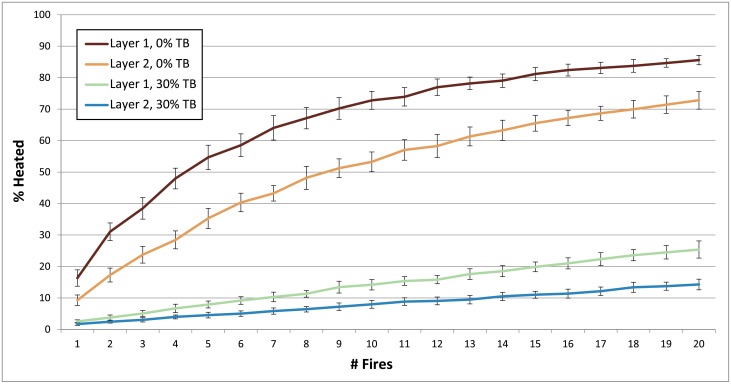
Chart demonstrating the effects of increasing the number of fires per occupation on fire proxy production for Layer 1 and Layer 2.Parameters: Fires Random/Lithic Scatters Random (FR/LSR), fire size 1, 4 lithic scatters, 30 occupations, 0% and 30% TB, 1% introduced lithics.